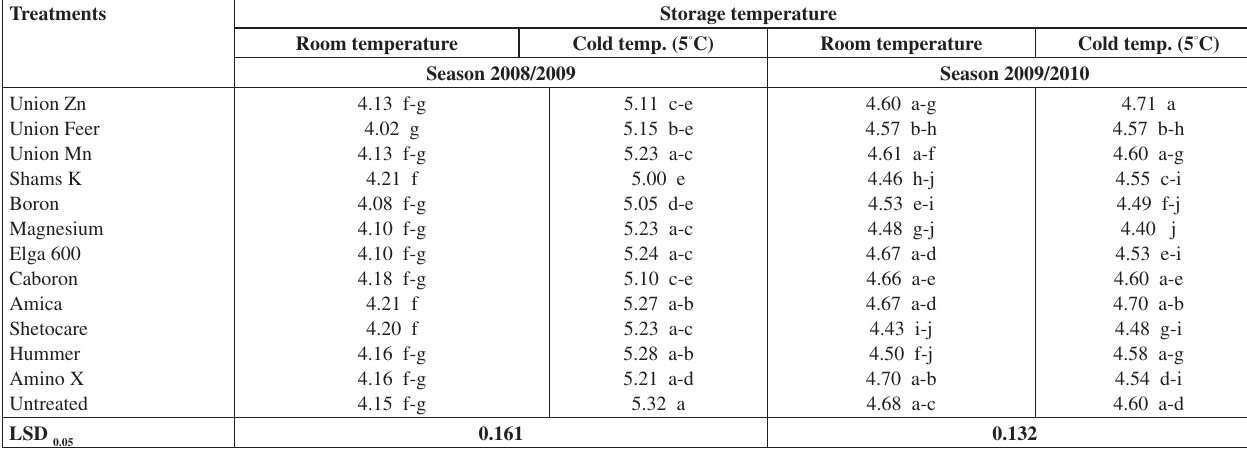
Table 12: Effect of the interaction between storage temperature and foliar application with commercial compound on water content (%) of onion seeds during seasons of 2008/2009 and 2009/2010 Treatments